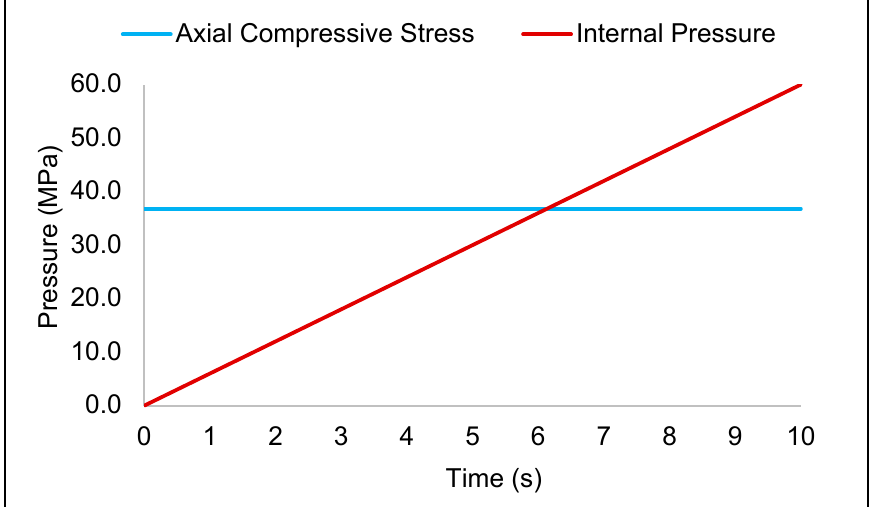
Figure 4. Application of axial compressive stress (normalised value of 0.5) and internal pressure during the transient analysis.